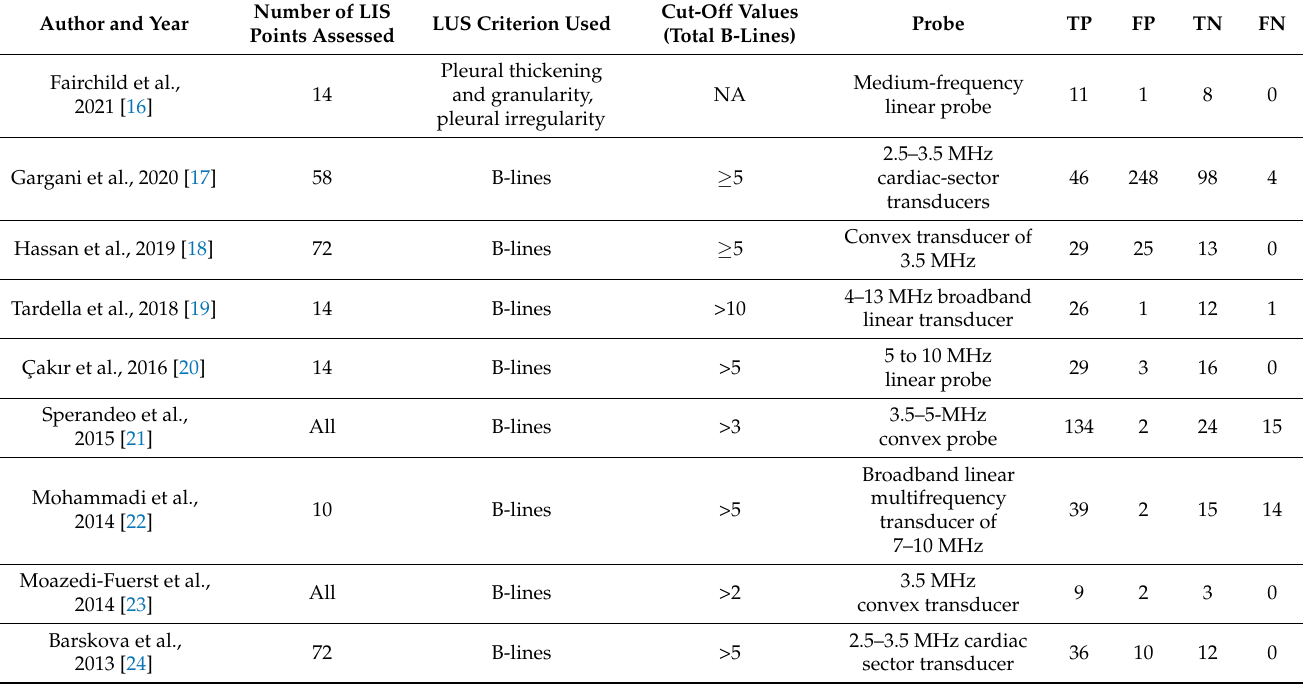
Table 2. Data for performing LUS